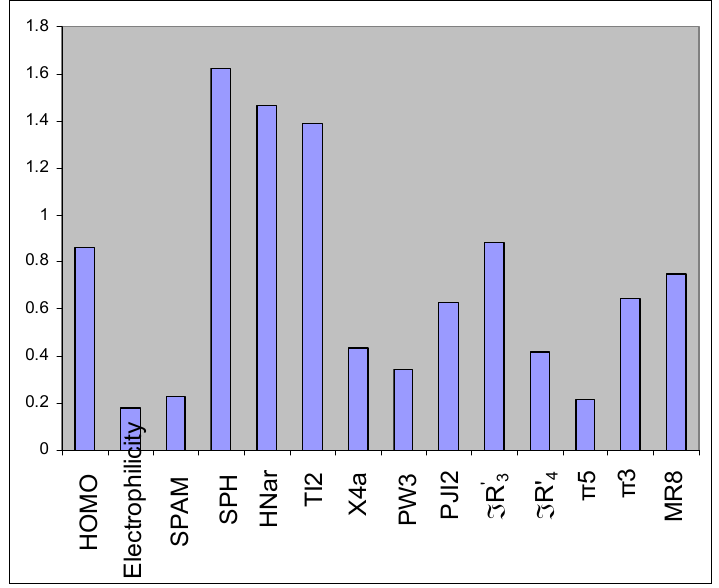
Figure 3. Plot of variables important in projection (VIP) for the descriptors used in GA- PLS